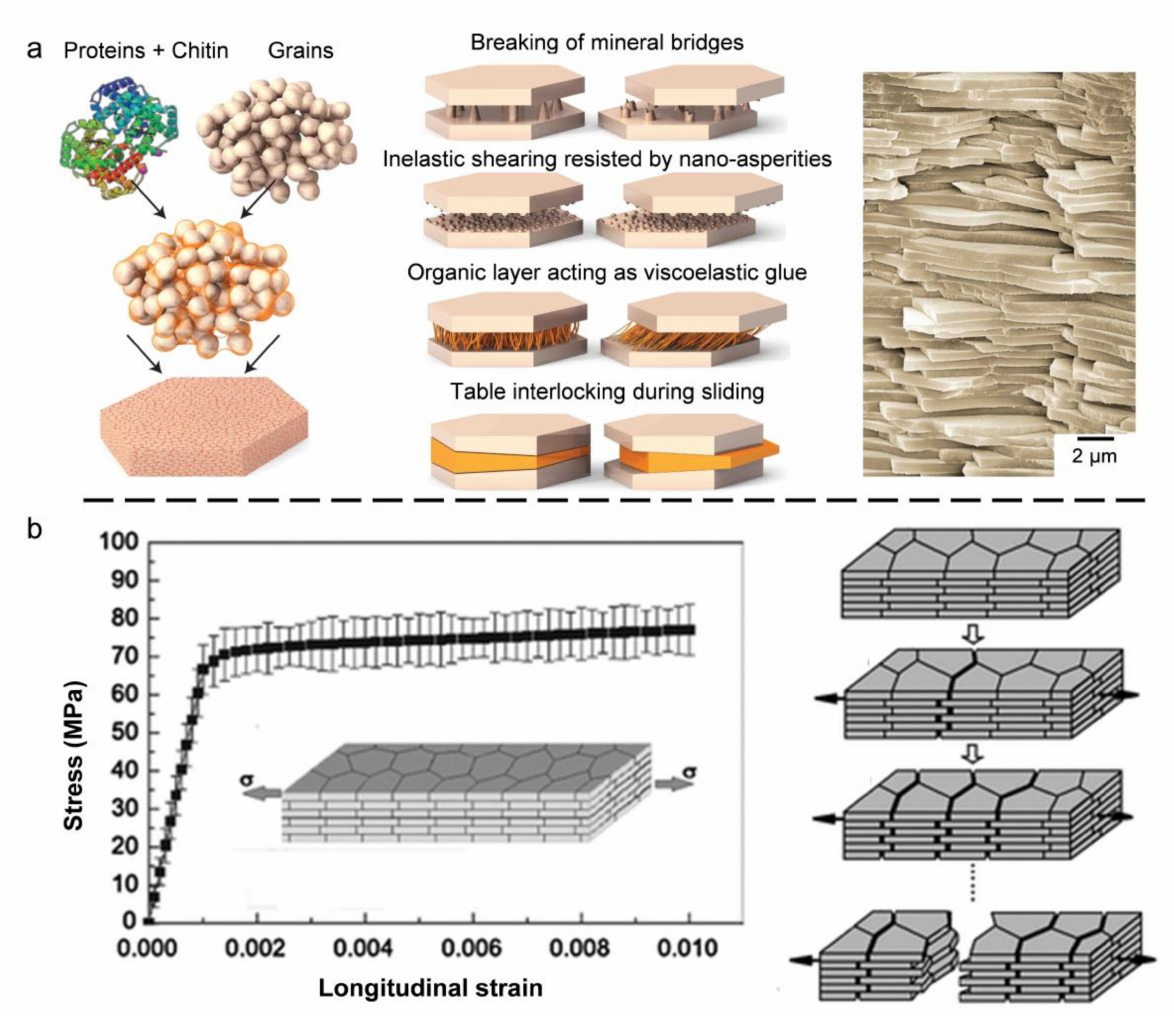
Figure 10. ( a ) Hierarchical structure and interface of a nacre. Reprinted with permission from [9], copyright 2015 NATURE RESEARCH. ( b ) The stress–strain curve during stretching of nacre and corresponding failure mechanism diagram. Reprinted with permission from [17], copyright 2012 ROYAL SOC